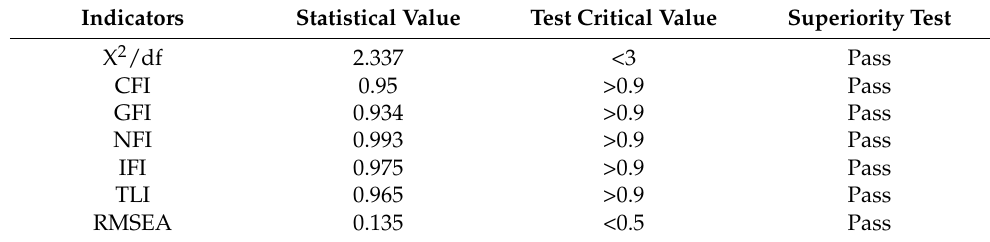
Table 5. Structural model goodness-of-fit index measures.